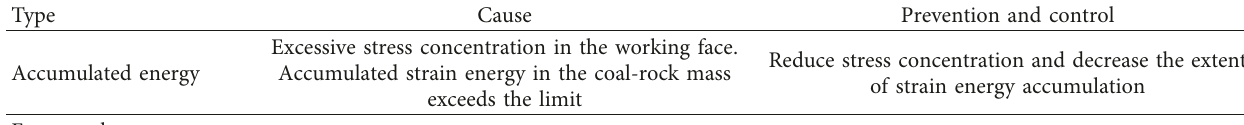
Table 2: Hard roof failure types, causes, and prevention methods.